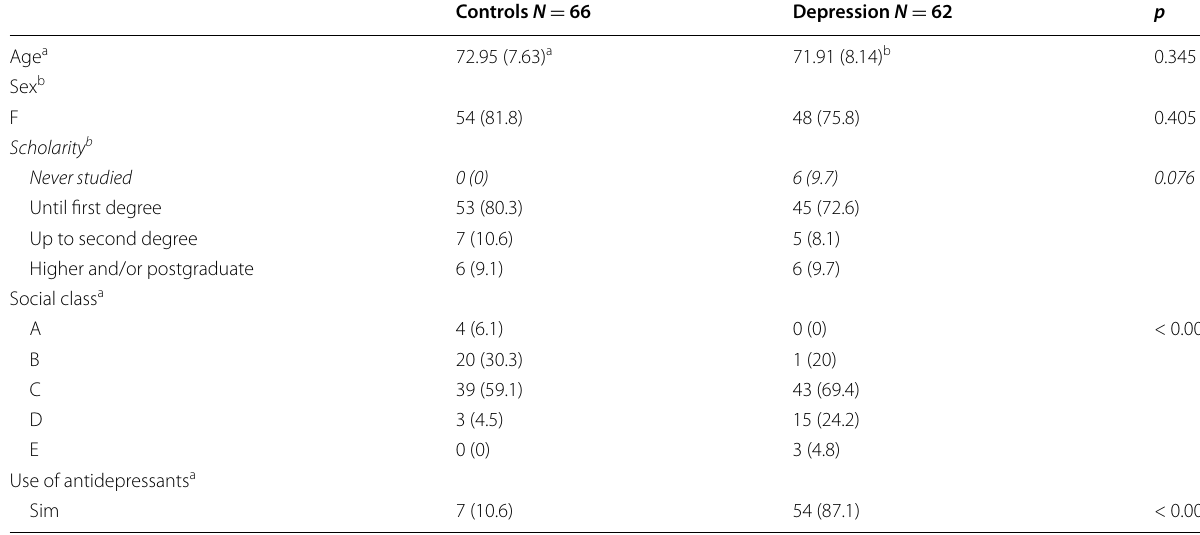
a Mann-Whitney U -test, results presented as mean and standard deviation b Chi-square, results presented in n (%)